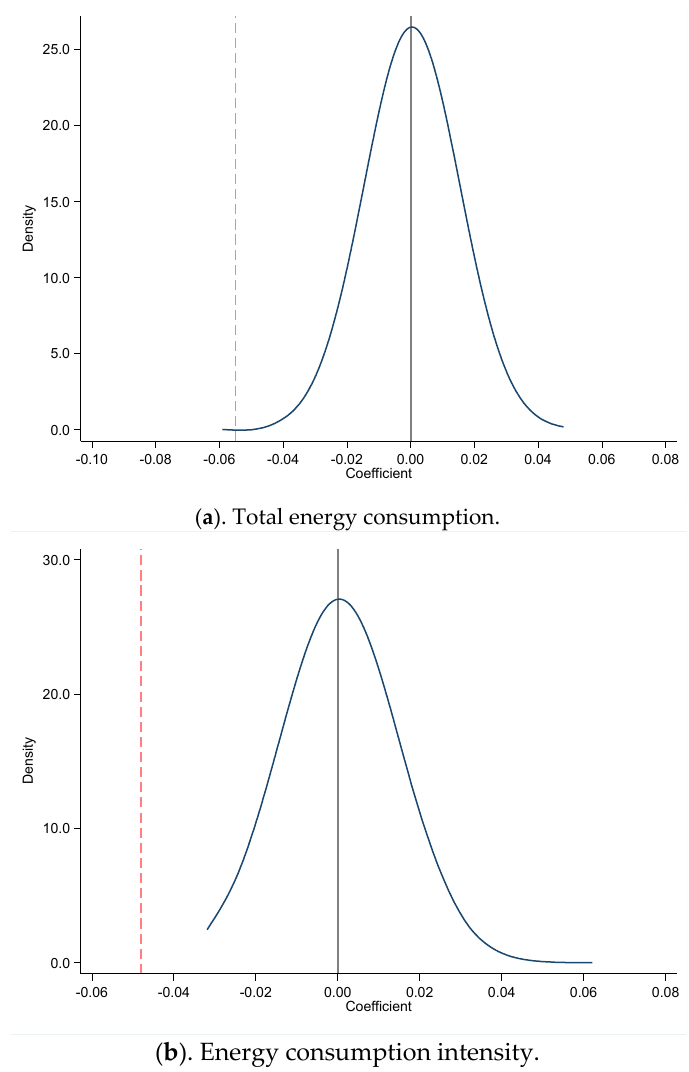
Figure 2. Kernel density plot of estimated coefficients. Table 5. Heterogeneous effects of energy quota trading on energy